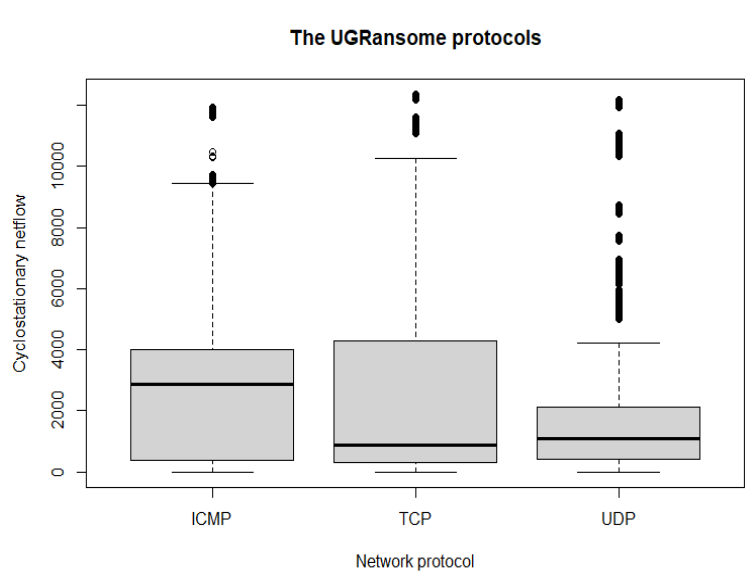
Figure 21. The UGRansome network protocols.